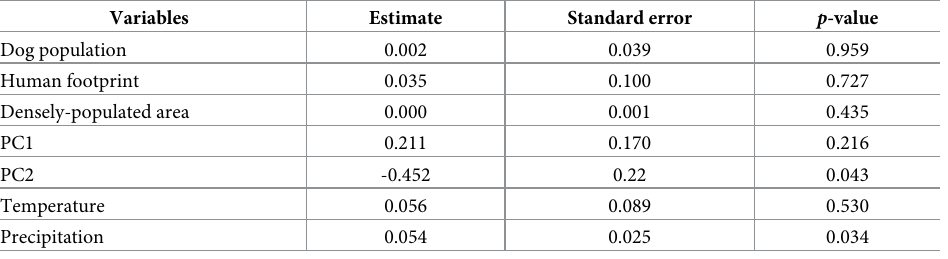
Table 4. Univariable analysis results for dog rabies cases in South Africa between 1998 and 2002 excluding the Kruger National Park.